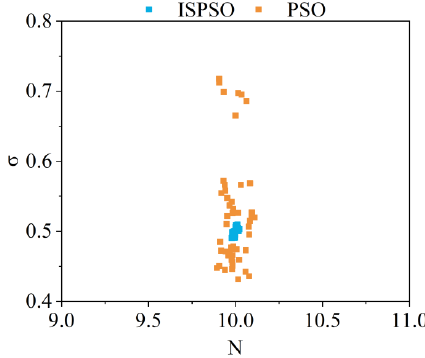
Figure A2. The 50-times calculation results of ( N , r m ).